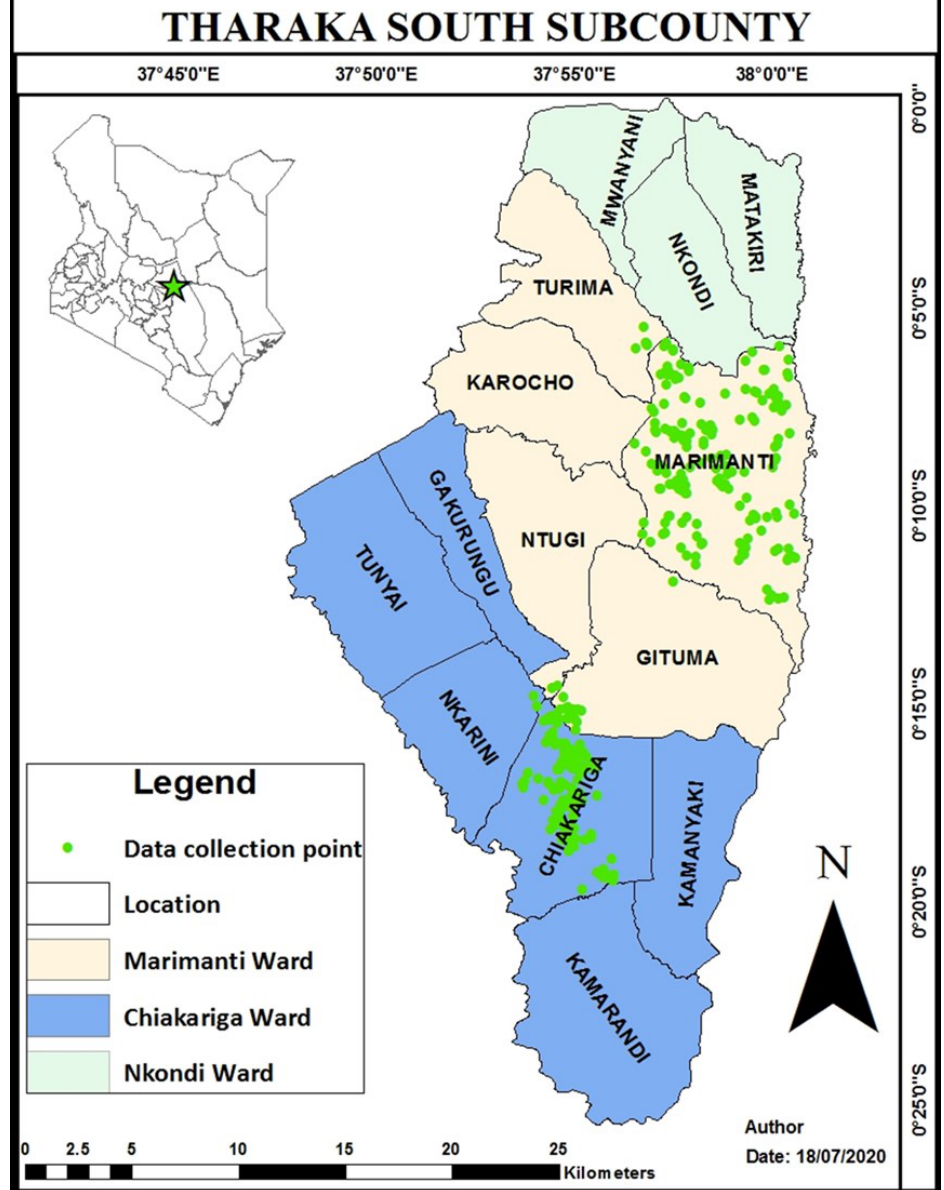
Figure 1. The study area in Tharaka South Sub